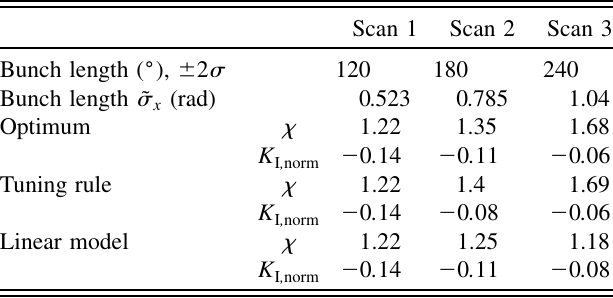
TABLE III. Tuning rule and linear model performance. Scan 1 Scan